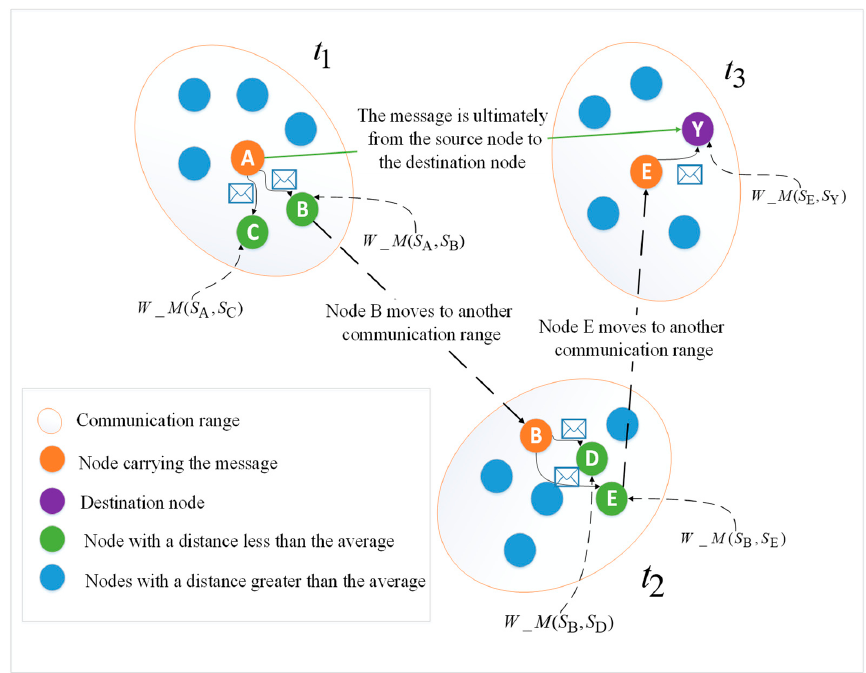
Figure 3. Model diagram of message forwarding strategy in opportunistic social networks.